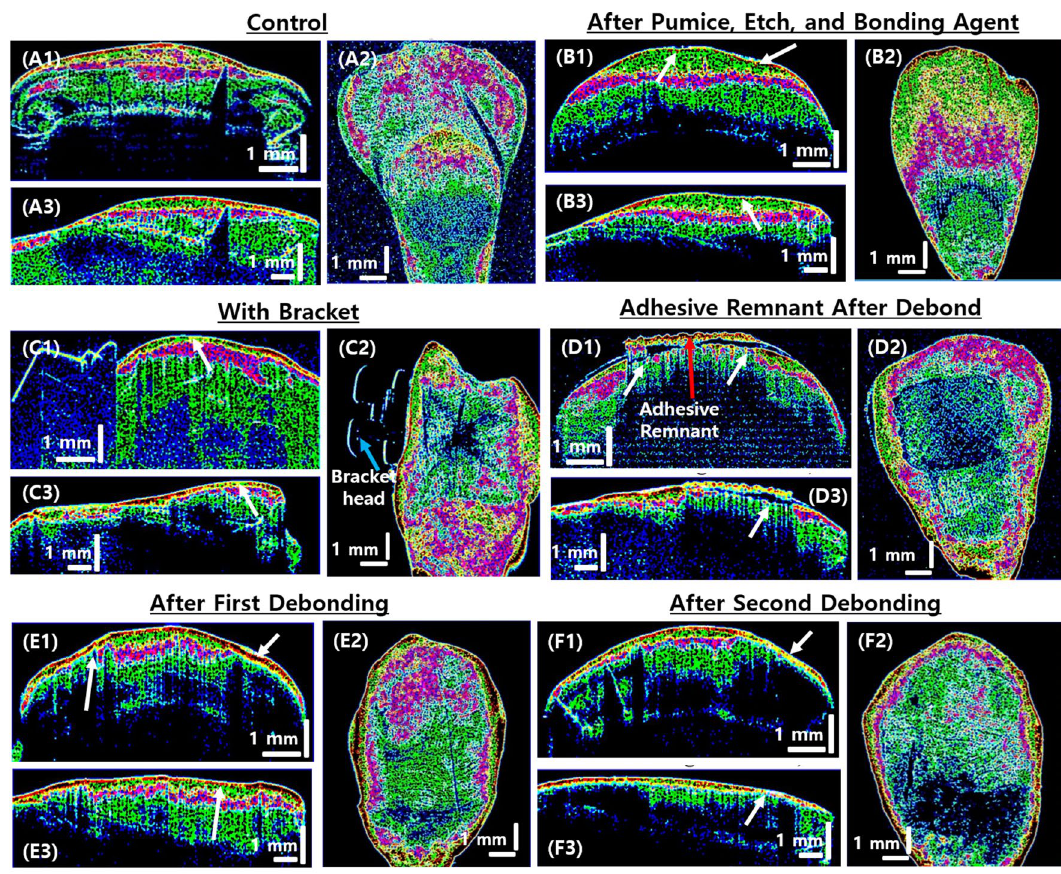
Figure 9. Layer segmentation analysis for internal enamel layer visualization in cross-sectional OCT images.2D cross-sectional OCT image in axial plane ( A1 , B1 , C1 , D1 , E1 , and F1 ) and sagittal plane ( A3 , B3 , C3 , D3 , E3 , and F3 ), and en face OCT images ( A2 , B2 , C2 , D2 , E2 , and F2 ) at 500 µm below the tooth surface. White arrows indicate enamel abrasion caused by treatment